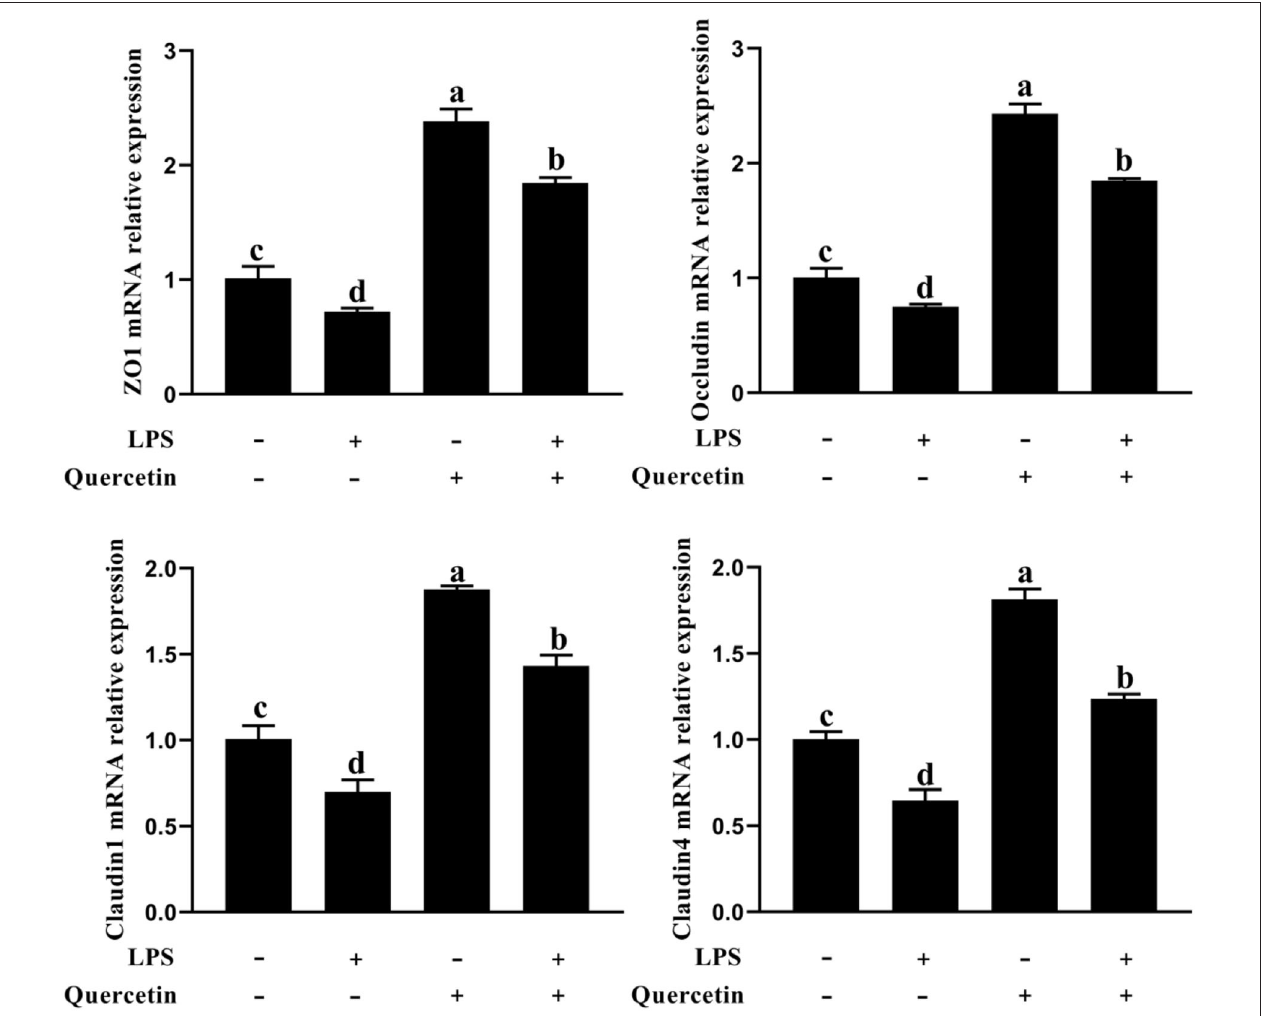
FIGURE 3 | Effects of quercetin on barrier function in LPS-induced BMECs. BMECs were treated with 100 µ g/ml of quercetin in the presence of 1 µ g/ml of LPS for 6h; messenger RNA (mRNA) expressions of zo-1, occluding, claudin 1, and claudin 4 in BMECs were assayed by qRT-PCR. Data presented are mean ± SEM ( n = 3). Different lowercase letters in the bar chart indicate significant differences ( P <